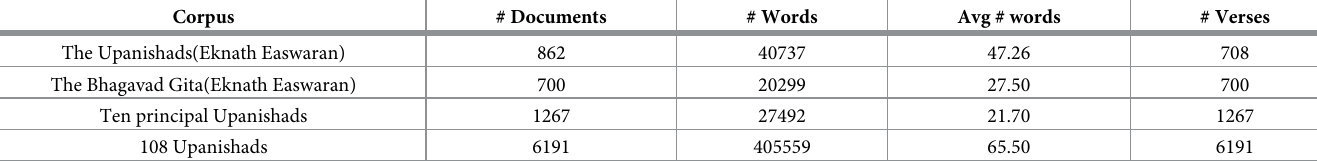
Table 3. Dataset